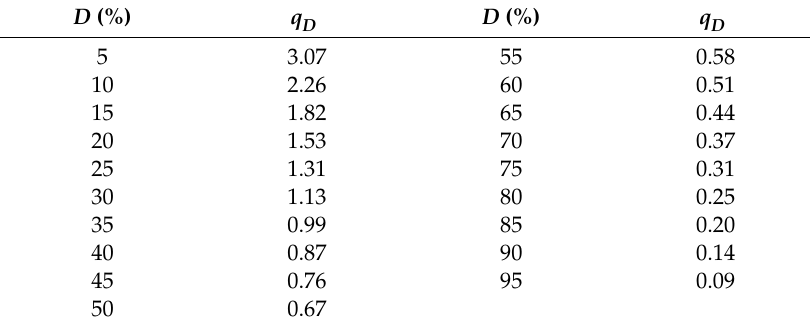
Table 8. Back transformation to the nondimensional flow duration curve (FDC) of the Ceyhan River